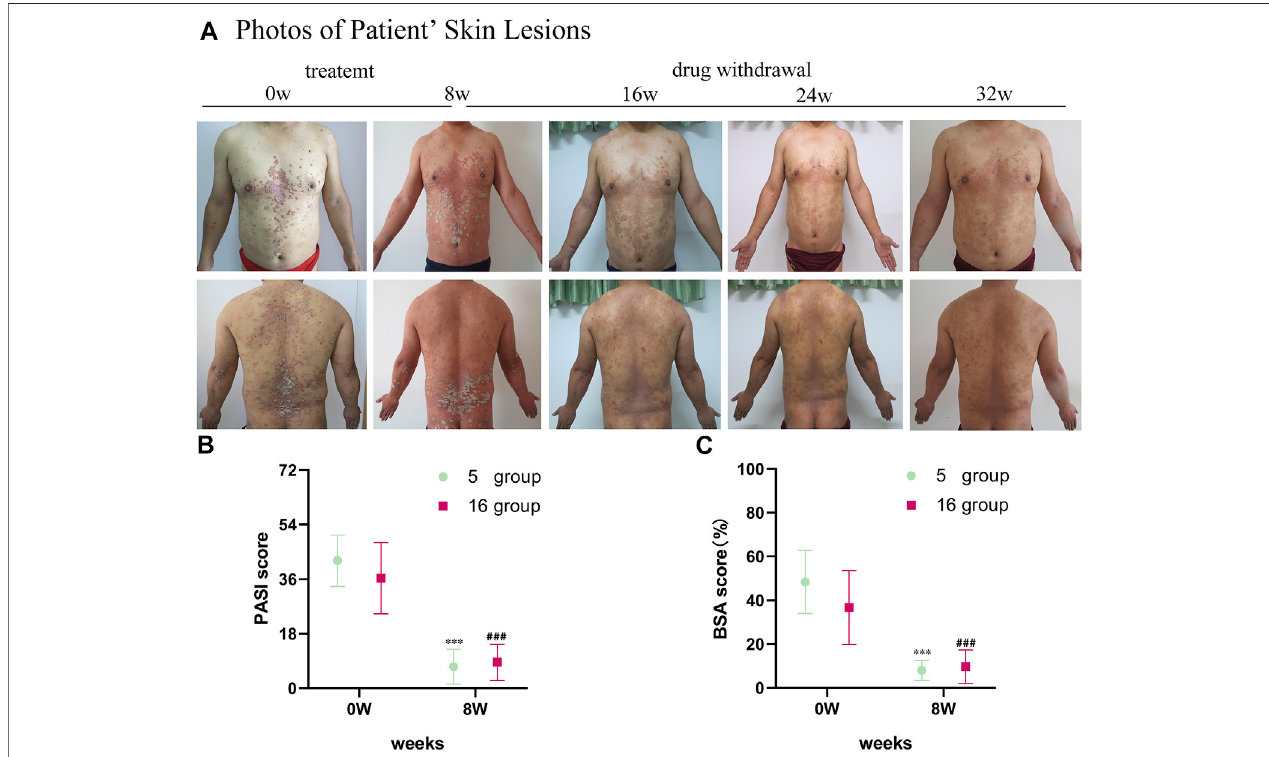
FIGURE 1 | Images of skin lesions and clinical data for patients with oxymatrine treatment. (A) Clinical photographs of skin lesions in the oxymatrine group before and 8 weeks after treatment. (B) PASI scores and (C) BSA scores of patients (before vs. after oxymatrine treatment). * p < 0.05, ** p < 0.01,*** p < 0.001 vs. before treatment (0 w in “ 5 group ” ), # p < 0.05, ## p < 0.01 ### p < 0.001 vs. before treatment (0 w in “ 16 group ”